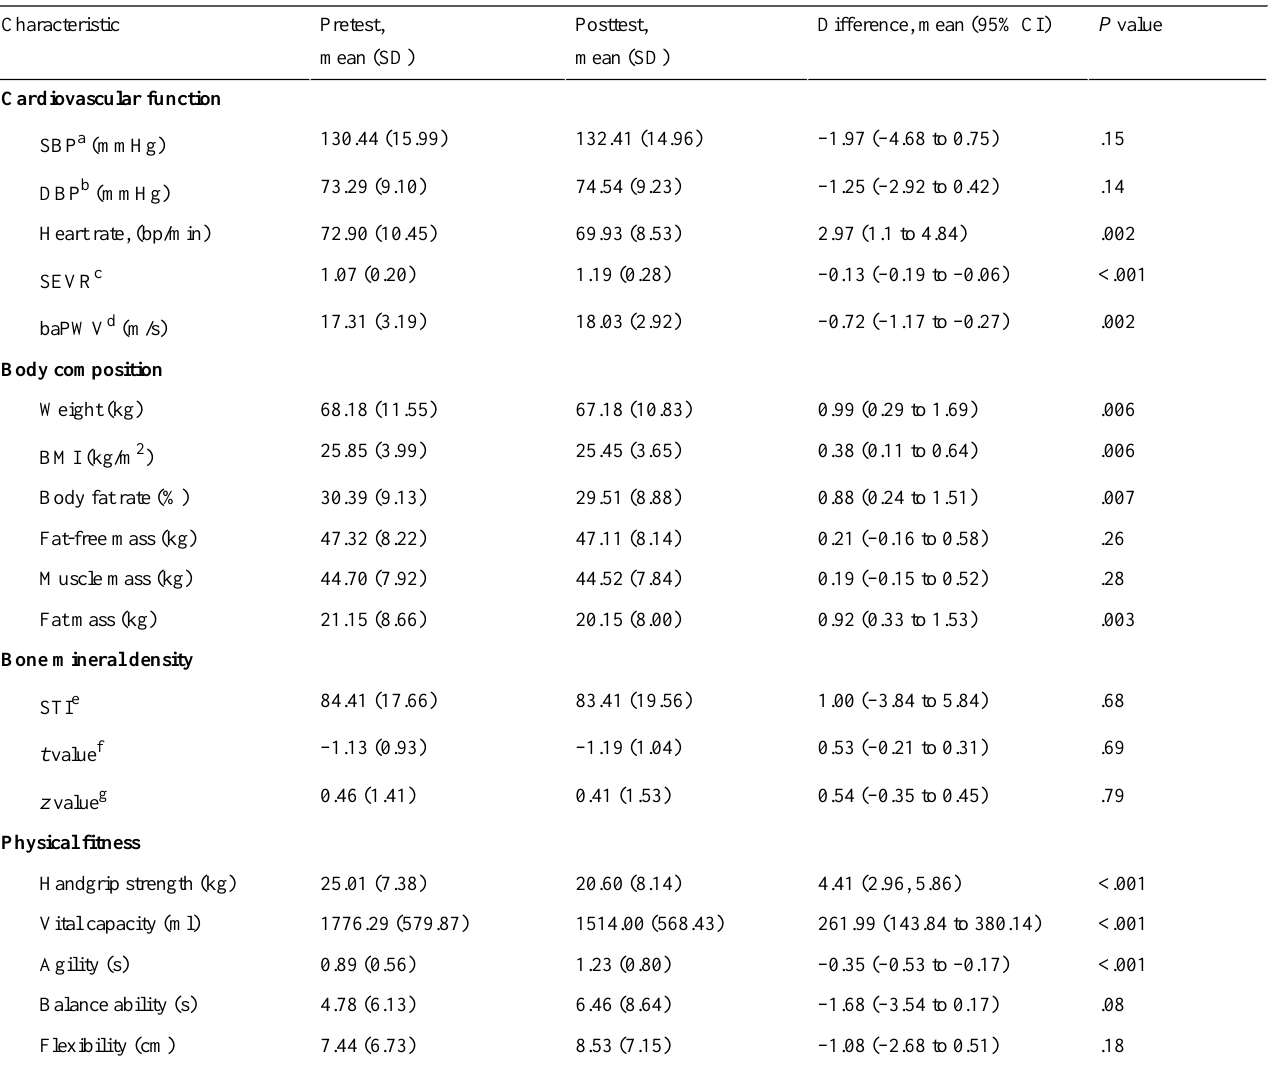
P valueDifference, mean (95% CI)Posttest,